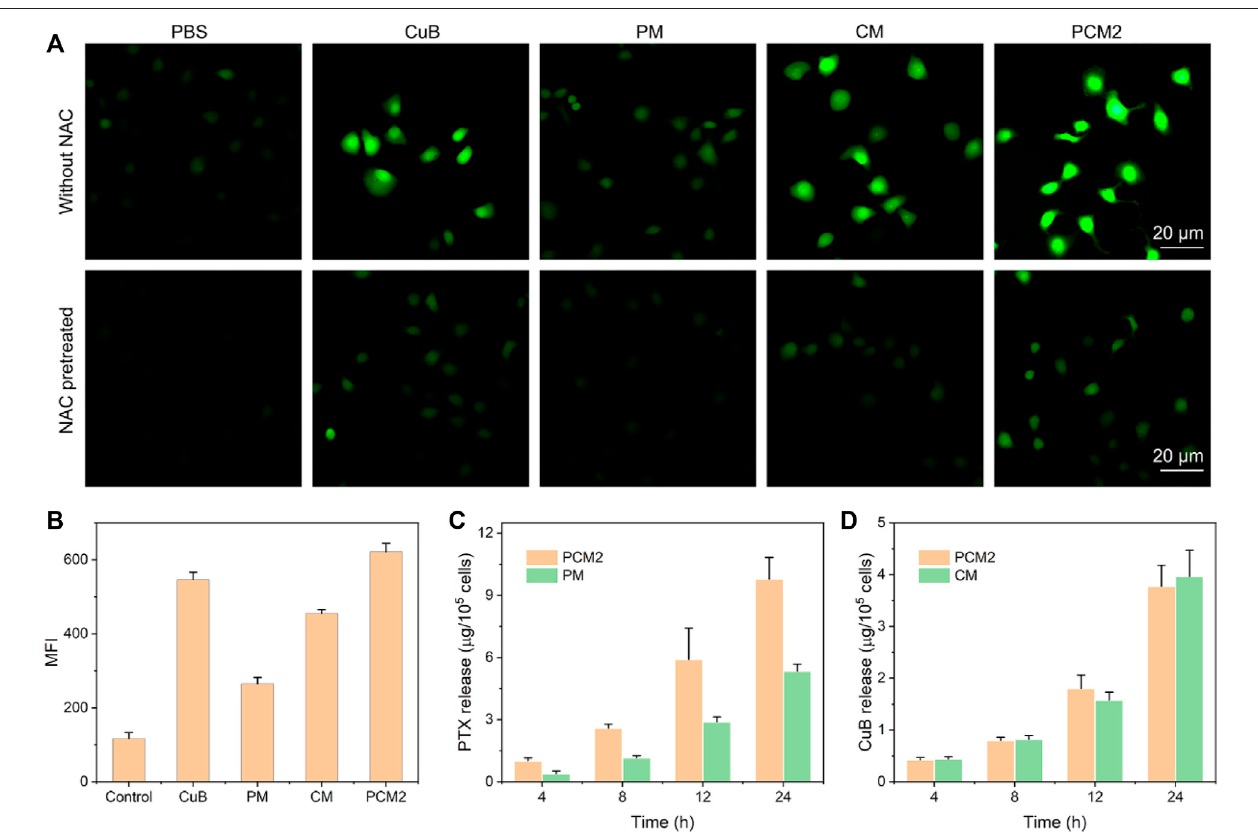
FIGURE4| IntracellularROSgeneration. (A) FluorescencemicroscopicimagesofBGC823cellsaftertreatmentwithPBS,CuB,CM,PM,orPCM2for4 hequalto 1 μ g/ml of CuB with or without NAC pretreatment. (B) Mean fl uorescence intensity (MFI) of BGC823 cells after being treated with free CuB, CM, PM, or PCM2 (equal to 1 μ g/ml of CuB) for 4 h (C,D) Intracellular release of PTX after incubation with PM and PM2 (C) and intracellular release of CuB after incubation with CM and PM2 (D) . Data in (B – D) were exhibited as the mean ± SD, n =